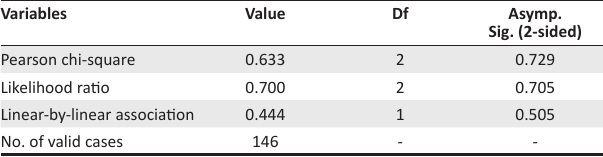
TABLE 3c: Border constraints: chi-square tests.